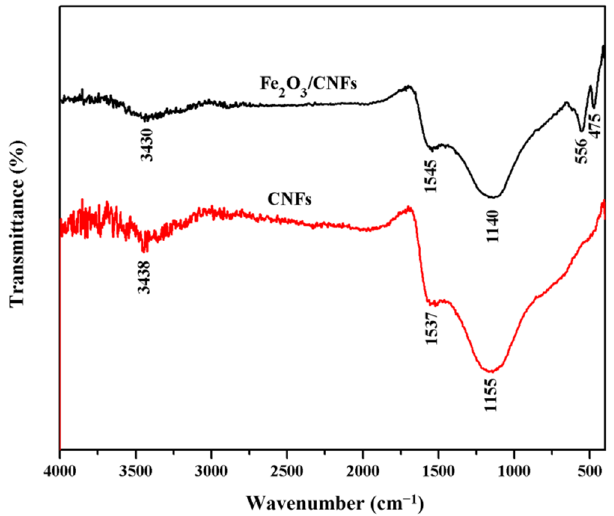
Figure 6. IR image of CNFs and Fe 2 O 3 /CNFs.